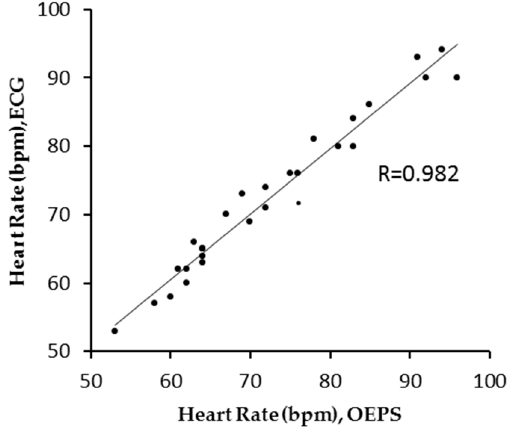
Figure 7. HR Correlation between OEPS and ECG with (r = 0.982) during rest mode.